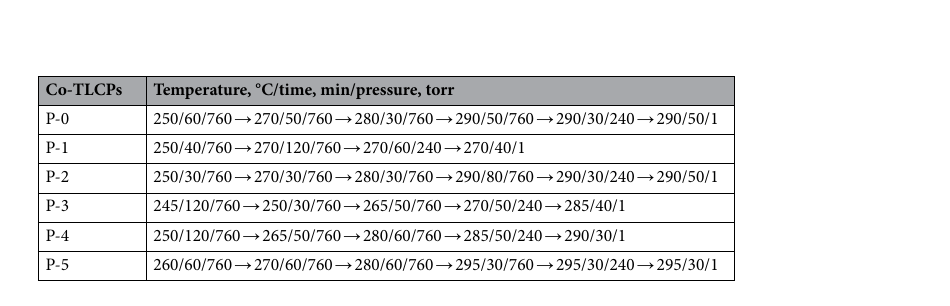
Table 1. Melt polymerization conditions of Co-TLCPs. a 2,5-Diethoxyterephthalic acid (DTA). b 2,7-Dihydroxynaphthalene (DHN). c 4-Hydroxybenzoic acid (HBA).